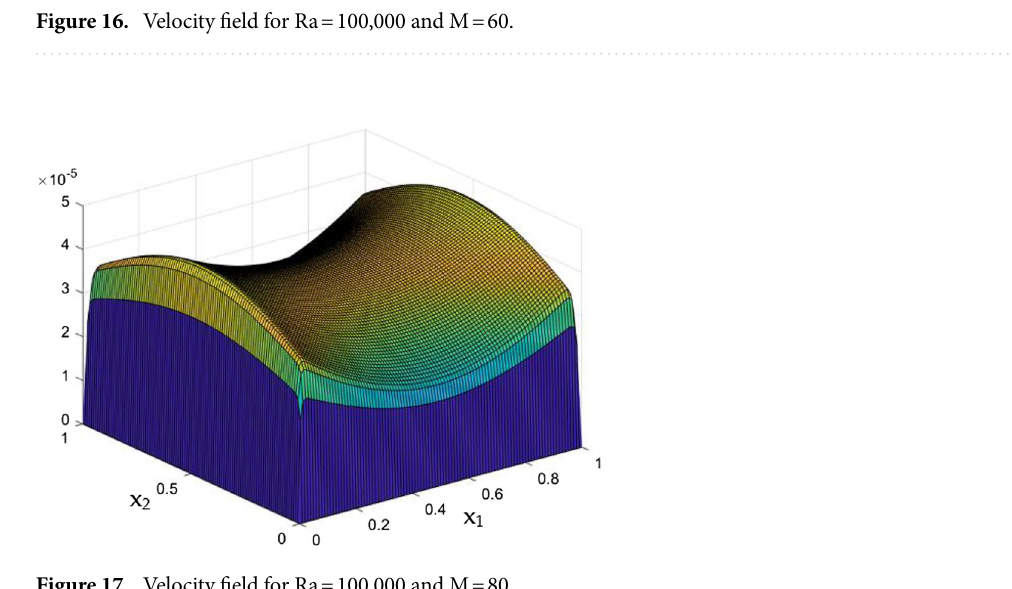
Figure 17. Velocity field for Ra = 100,000 and M = 80.